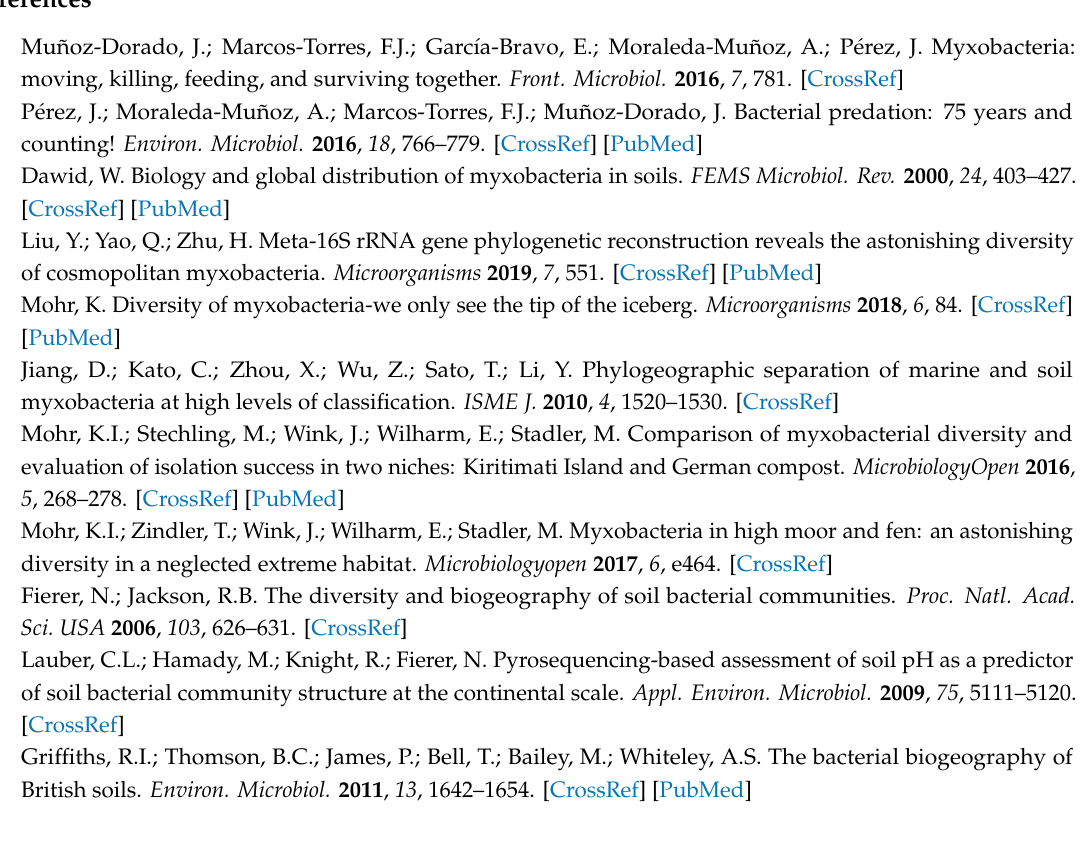
Table S1: The scores and variance percentages of axis by principal coordinate analysis (PCoA) of bacterial community from forest soil in the field investigation. Bact1 and Bact2 represent the first two axis were used as indicators of bacterial community. Table S2: The scores and variance percentages of the axis indicated by principal coordinate analysis (PCoA) of soil bacterial community from rhizosphere in the greenhouse mesocosm. Bact1 and Bact2 represent the first two axes used as indicators of bacterial community. Table S3: Correlation between ordination axis and constrained factors in the greenhouse mesocosm. Monte Carlo permutation test was used to evaluate significance. R 2 means the e ff ect size of specific factor on soil myxobacteria, and p < 0.05 mean significant factor e ff ect on myxobacterial community. Bact1 and Bact2 indicate the first and second axes generated from principal coordinate analysis (PCoA) using soil microbial community composition data. Bact_abundance mean the copy numbers of soil bacteria from qPCR. Table S4: Topological properties of the plant-associated co-occurrence network of bacterial community and the random network from rhizosphere in the greenhouse mesocosm. Figure S1: Redundancy analysis (RDA) of soil myxobacteria community composition constrained by soil bacterial community and soil property in the greenhouse mesocosm. Bact1 and Bact2 mean the first and second principal components generated from principal coordinate analysis (PCoA) using soil microbial community composition data. Bact_abundance mean the copy numbers of soil bacteria from